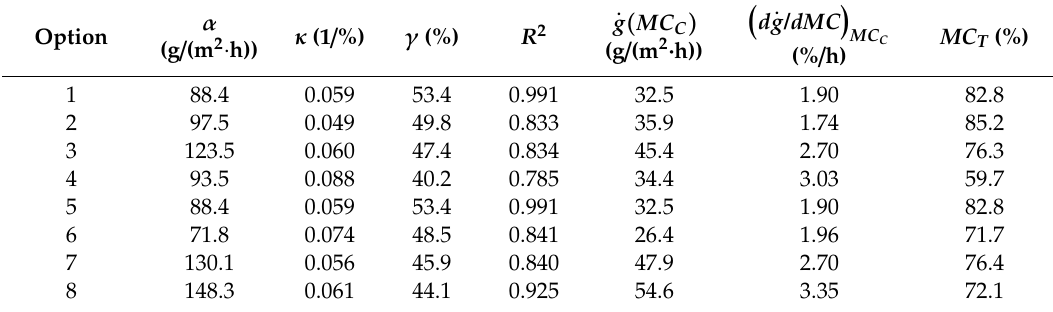
Table 3. Estimated parameters of the Gompertz model together with the quantities derived from the